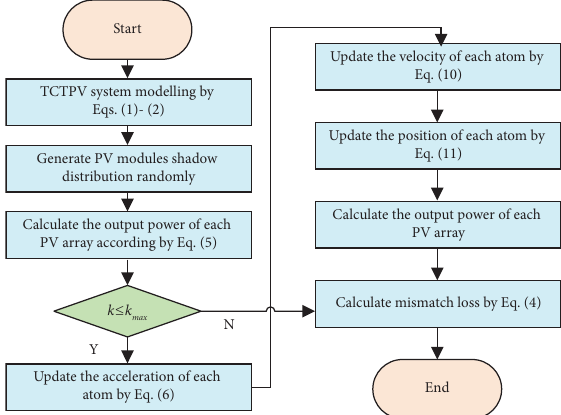
Figure 4: Flowchart of PV reconfguration based on